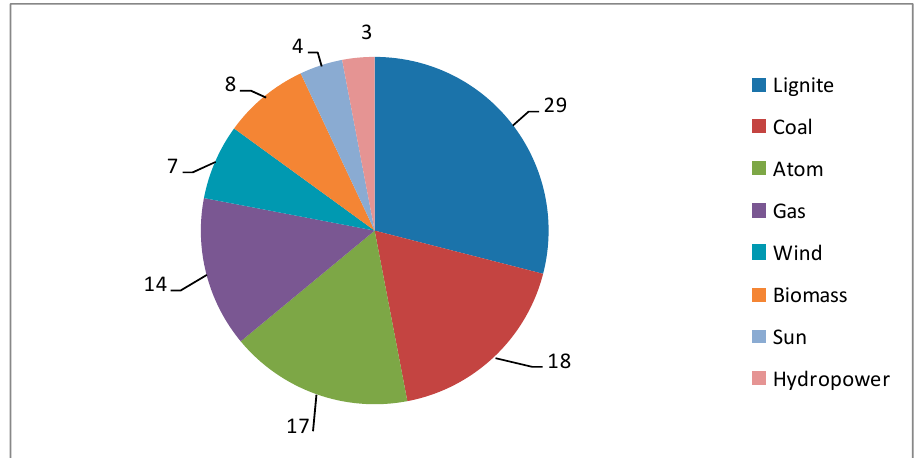
Figure 11. Electricity production by source in Germany in 2019 (in terms of percentage) [61].